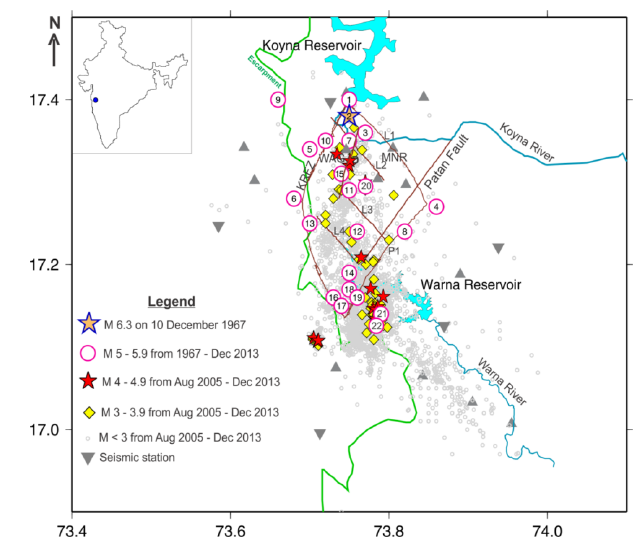
Figure 1. Seismic stations and earthquakes in Koyna–Warna re- gion. KRFZ: Koyna River fault zone; D: Donichiwada Fault; P1: fault parallel to Patan Fault; L1, L2, L3, and L4: NW–SE trending fractures. Inset: Koyna on India’s map.